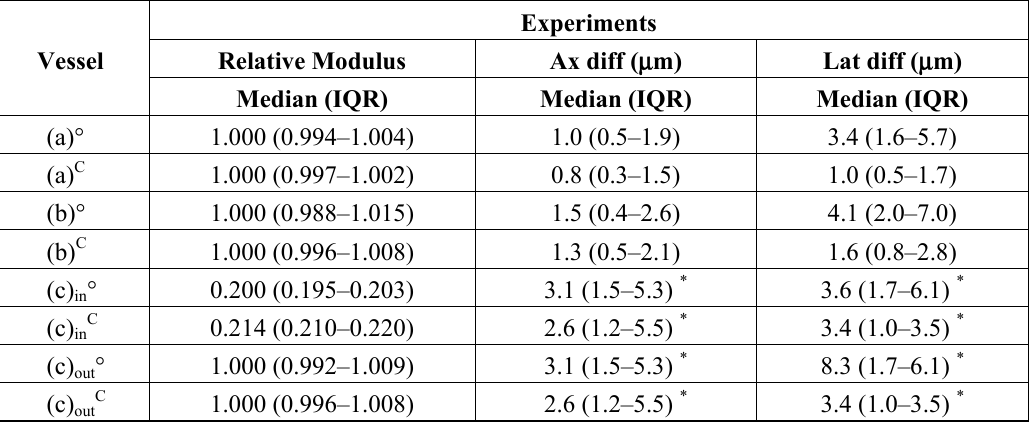
Table 2. Median and interquartile ranges (IQR) for the modulus reconstruction of the three vessels based on experiments. The median and IQR for the absolute differences between the input and output displacement fields are reported